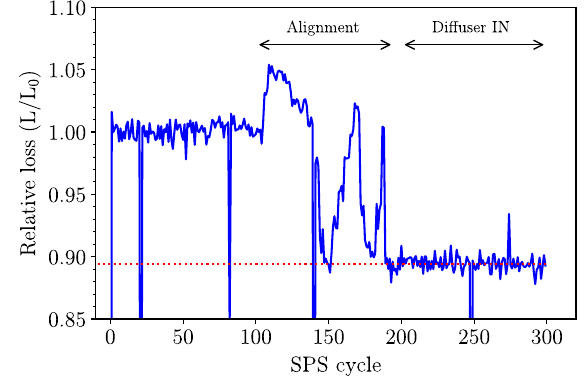
FIG. 12. Normalized SPS beam loss (sum on all BLMs around the full ring) spanning 300 cycles (about 3 hr) around the insertion of the prototype diffuser into the operational beam.